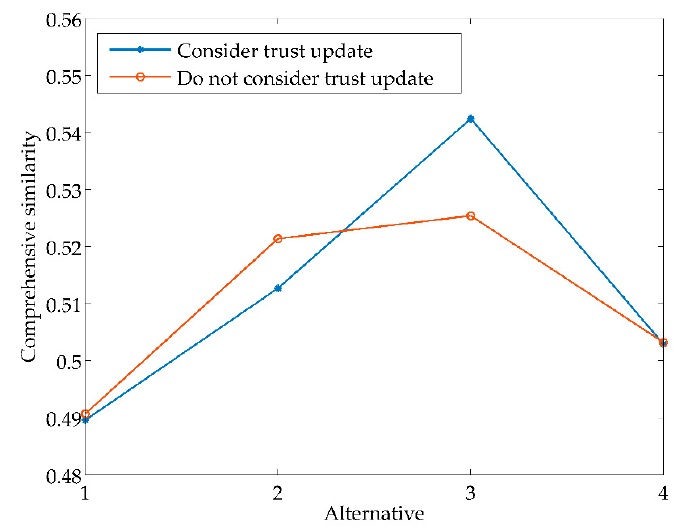
Figure 4. The influence of trust updating on decision results.